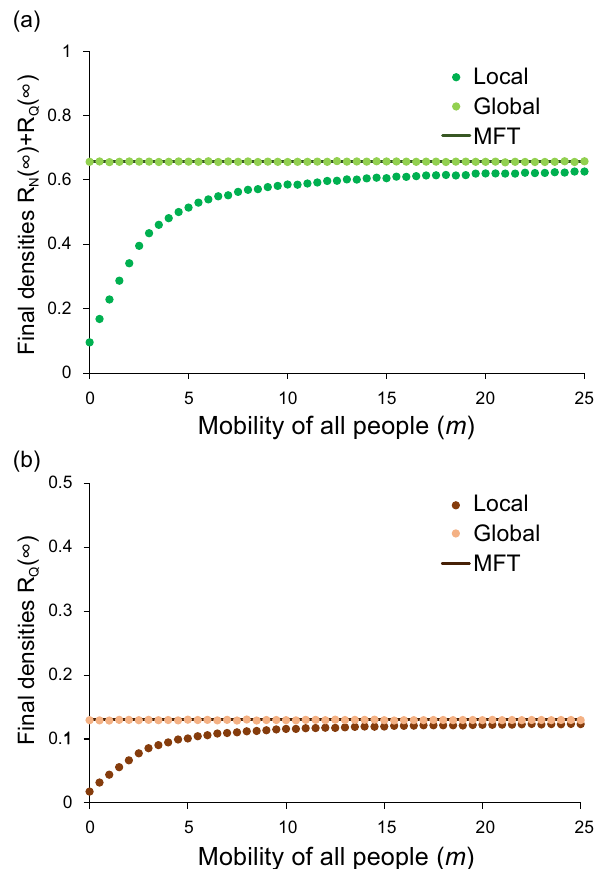
Figure 3. Results of random-walk simulation at the final stage ( t = 1000 ). All people (agents) randomly migrate with the same migration rate ( m ) on a lattice ( 100 × 100 ). In ( a ) and ( b ), the total infection [ R N ( ∞ ) + R Q ( ∞ ) ] and apparent infection [ R Q ( ∞ ) ] are plotted against m , respectively. The straight lines indicate the results of MFT which agree with those of global